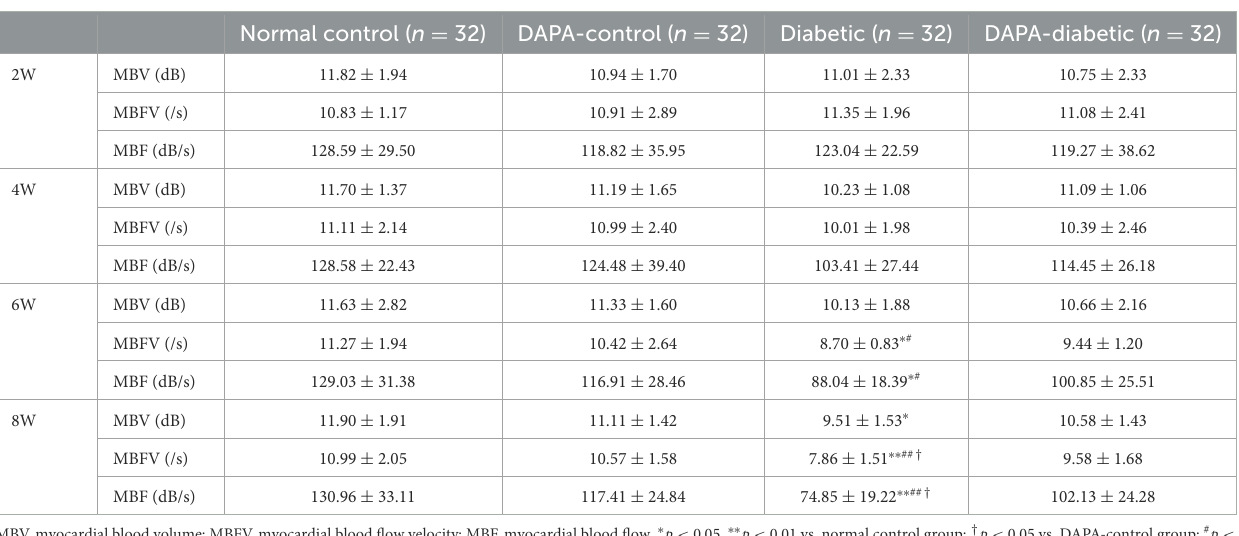
TABLE 3 Changes in myocardial perfusion parameters by MCE.